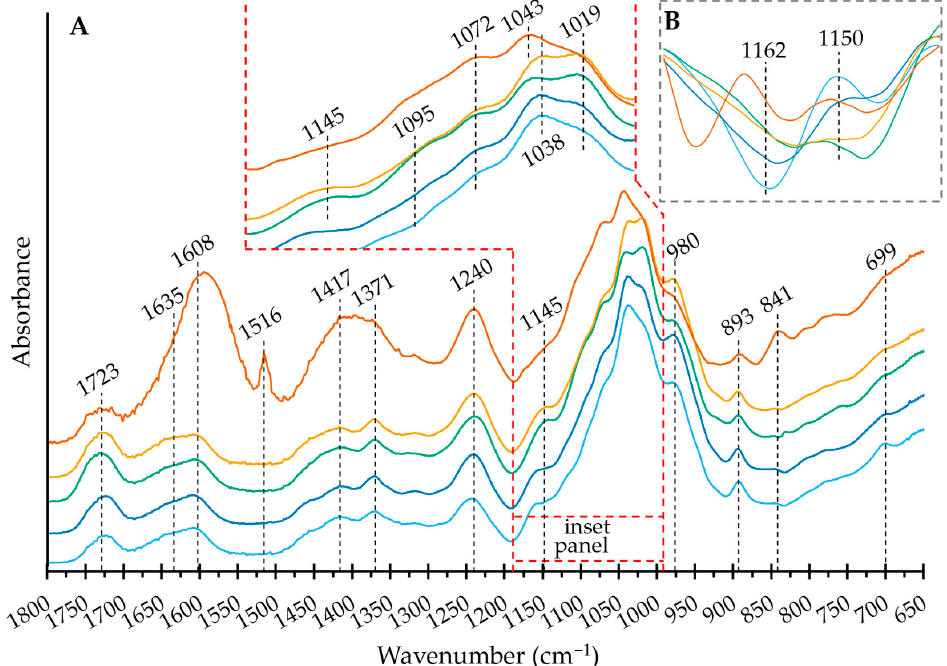
Figure 3. ( A ) FT IR spectra of the mucilage extracted from O. joconostle cladodes and its composing polysaccharides in the 1800–650 cm − 1 range. OXO M (orange), OXO N (light blue), OXO 0.2 (dark blue), OXO 0.4 (green), OXO 1.0 (yellow). ( B ) Second derivative of the FT IR spectra (1132–1180 cm − 1 range). Refer to Section 2.4. in the text for the band assignments.